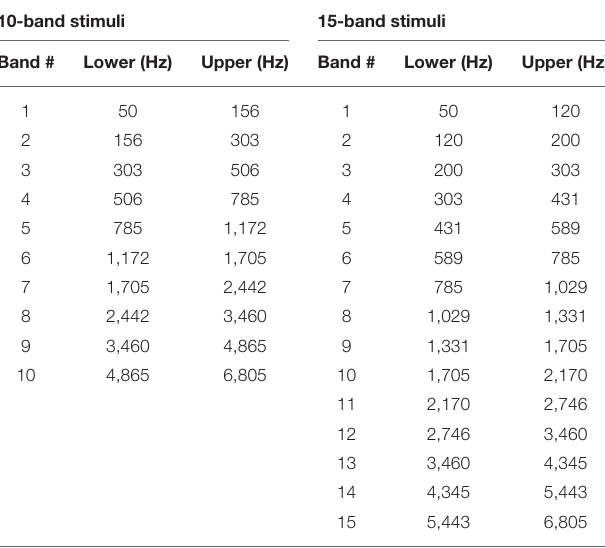
TABLE 2 | Cutoff frequencies for the 10-band and 15-band stimuli.